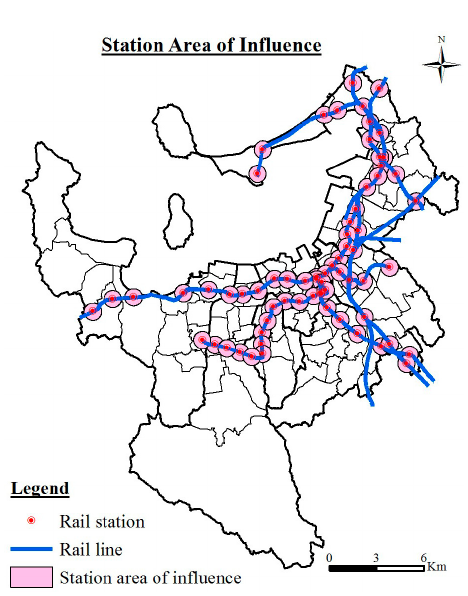
Figure 3. Station area of influence.